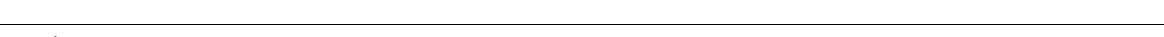
TABLE 3 | Mean densities and velocities from criterion 2 and corresponding frequencies. Group size 100 pedestrians 350 pedestrians Analysis n